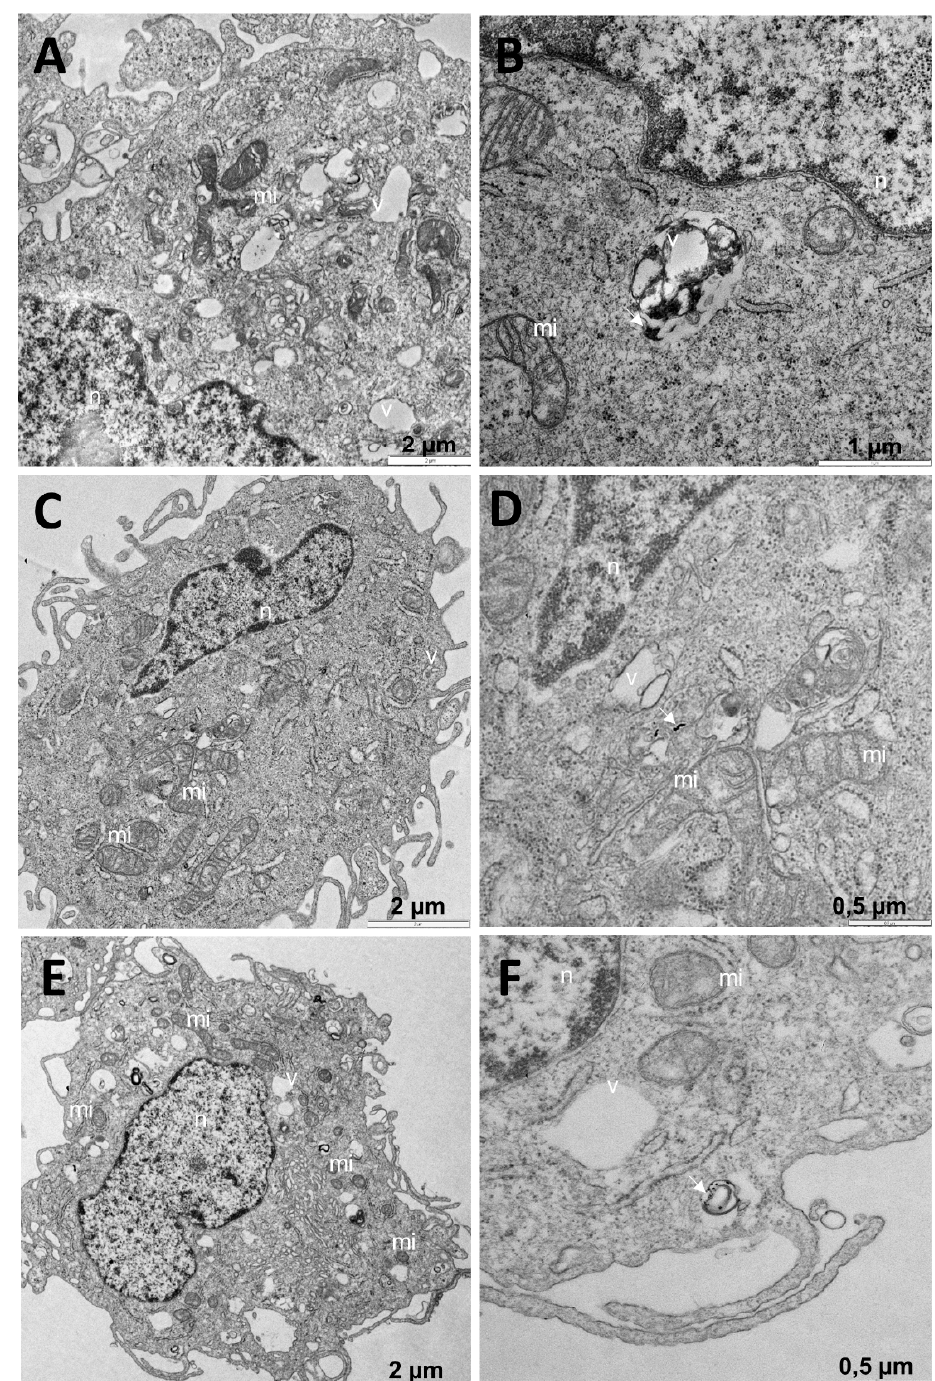
Figure 10. TEM images for BJ-hTERT cells, treated with Au@16-Ph-16/DNA–5-Fu-compacted nanosystems: C 1 ( A , B ), C 2 ( C , D ), and C 3 ( E , F ), arrows indicate the presence of nanoparticles ( D , F ). Abbreviations: mi: mitochondria; n: nucleus; v: vesicle.